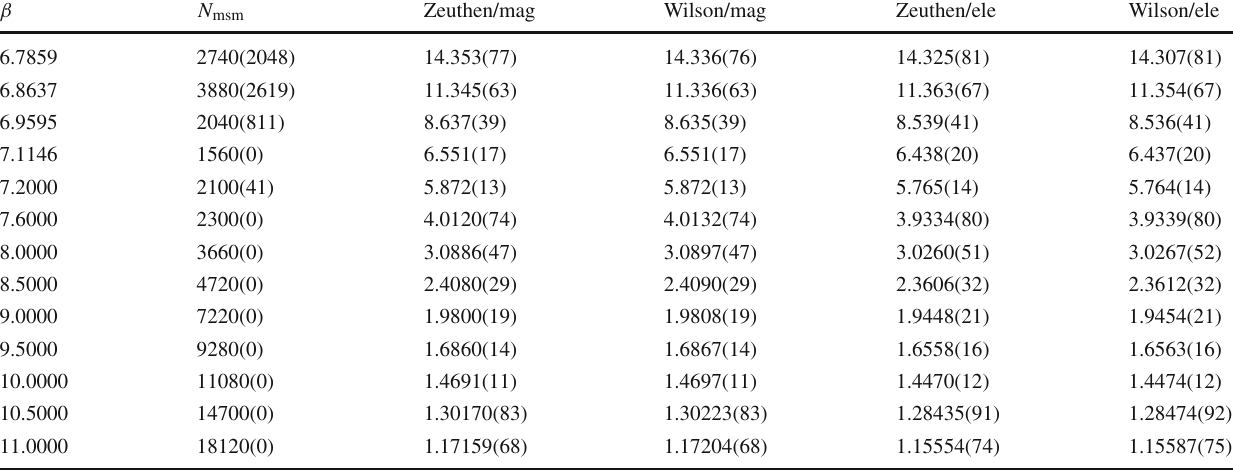
Table 9 GF coupling data for L / a =